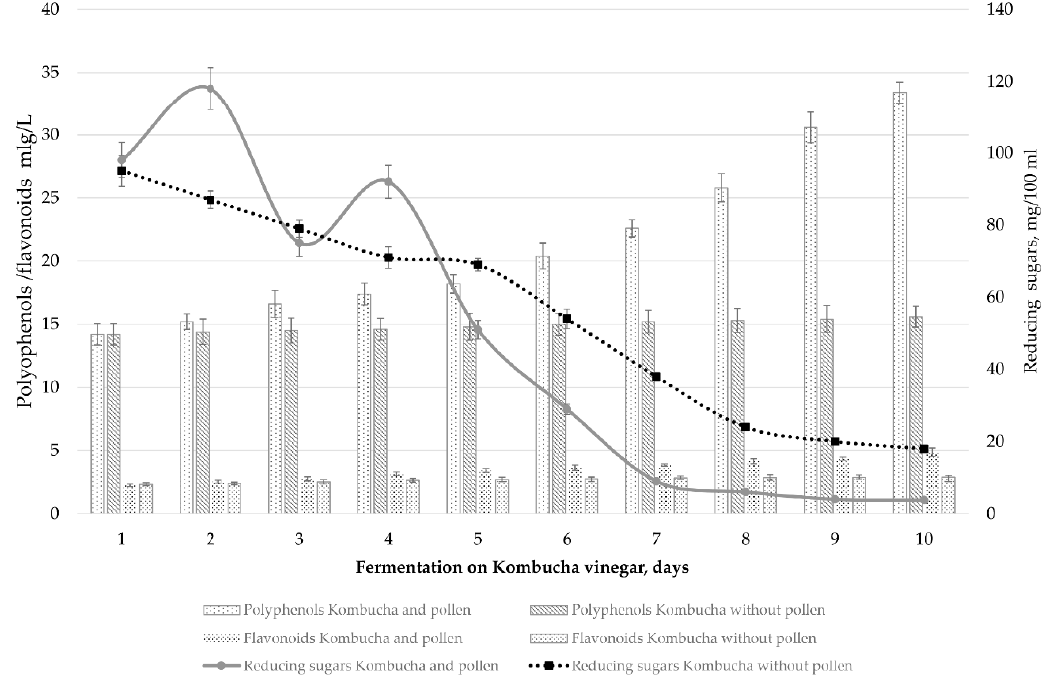
Figure 2. Evolution of polyphenols, flavonoids and reducing sugars of Kombucha vinegar wherein bee collected pollen was introduced.